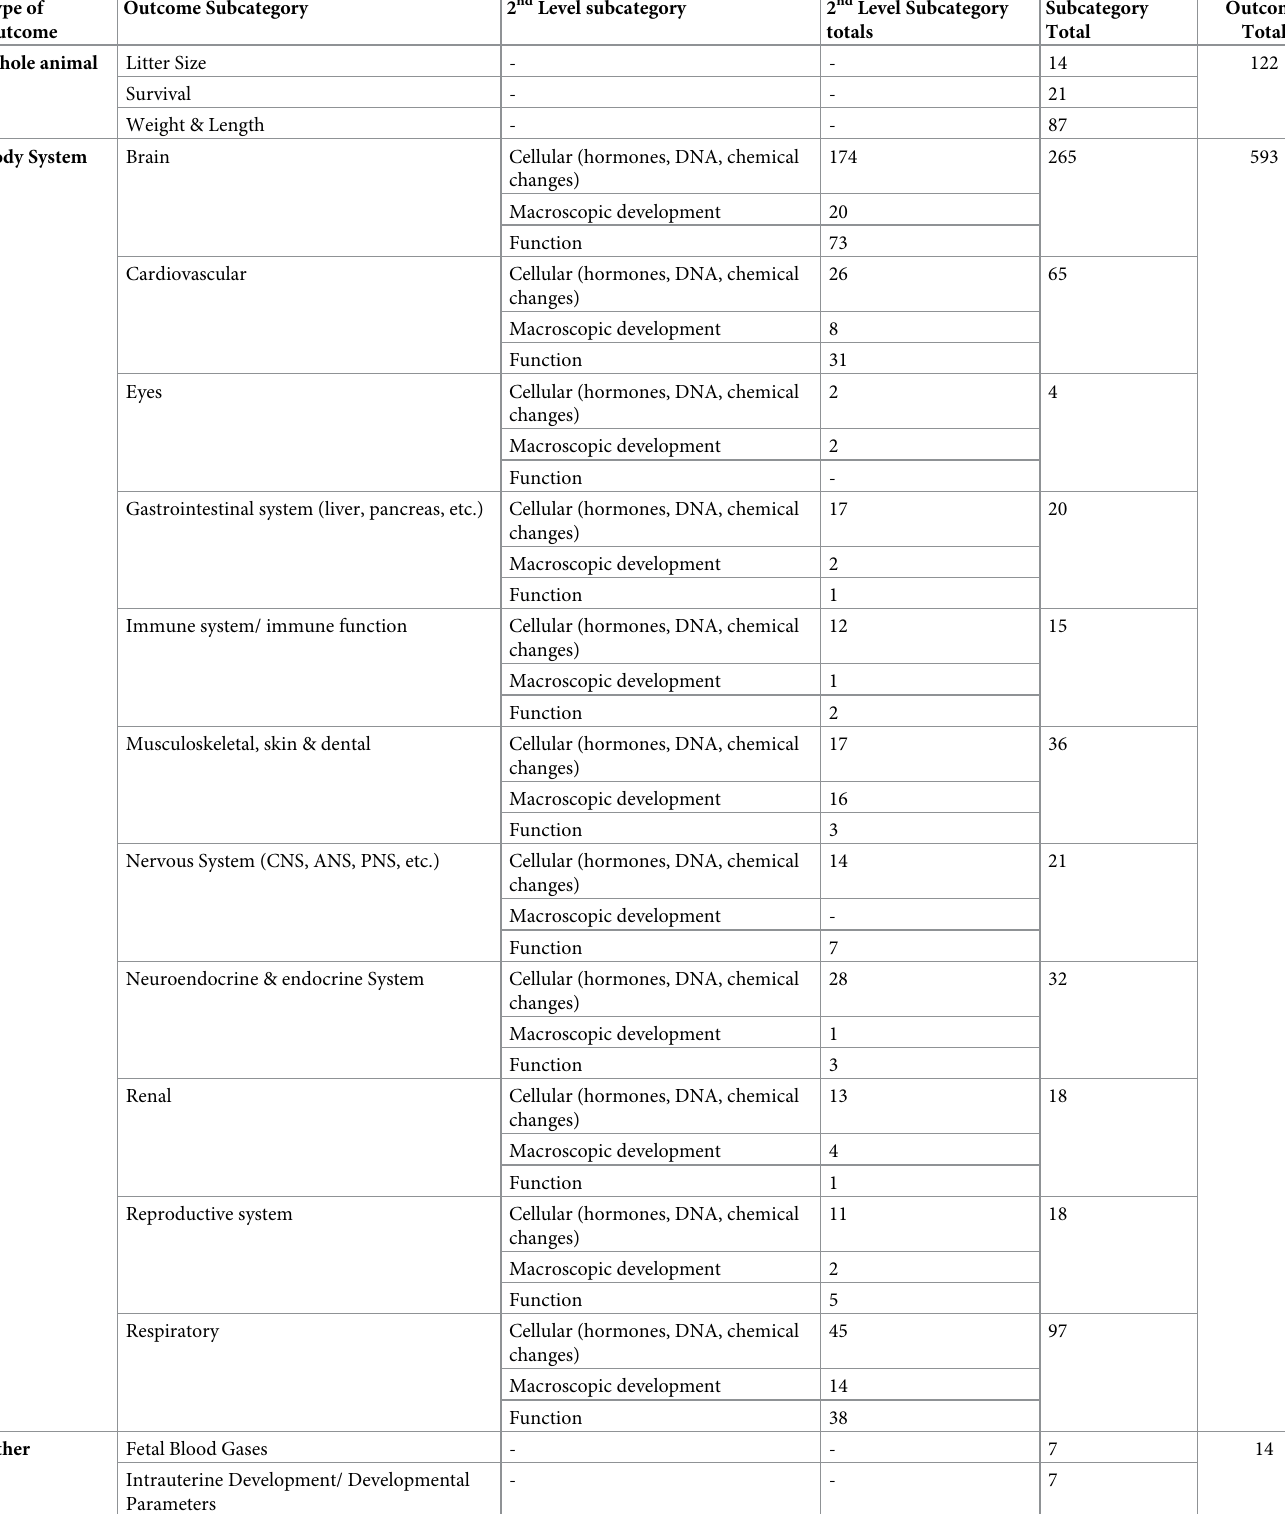
Table 2. Draft taxonomy for categorising outcomes in preclinical